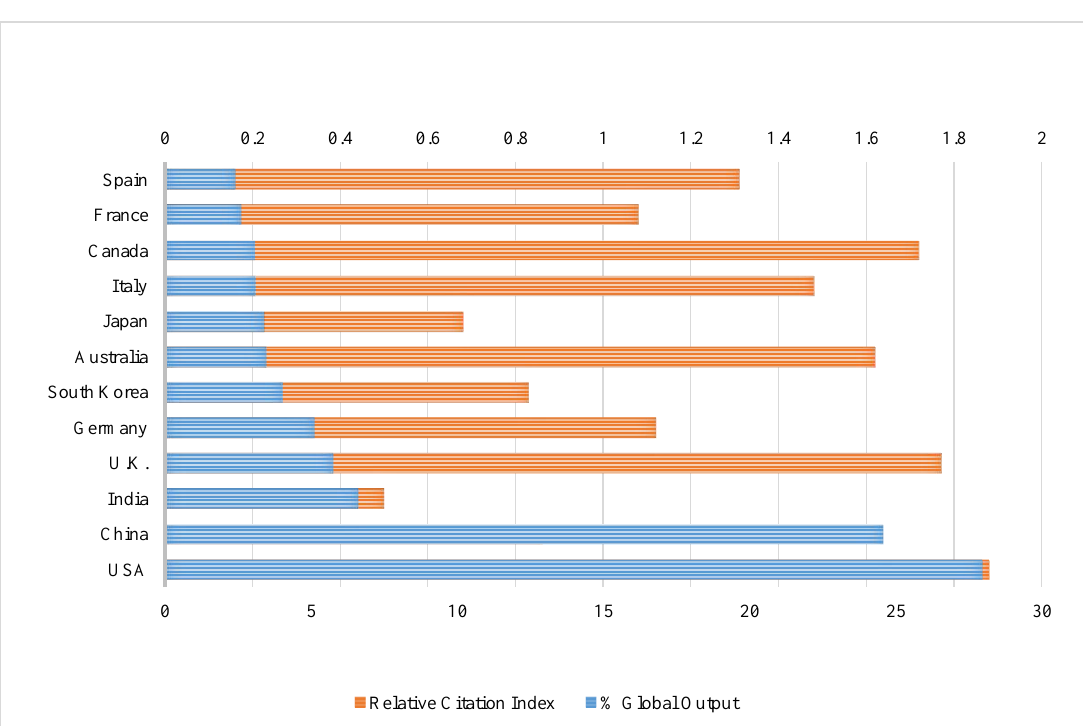
Figure 2. Quantity & Quality Comparative Study of Top Most Productive Countries: